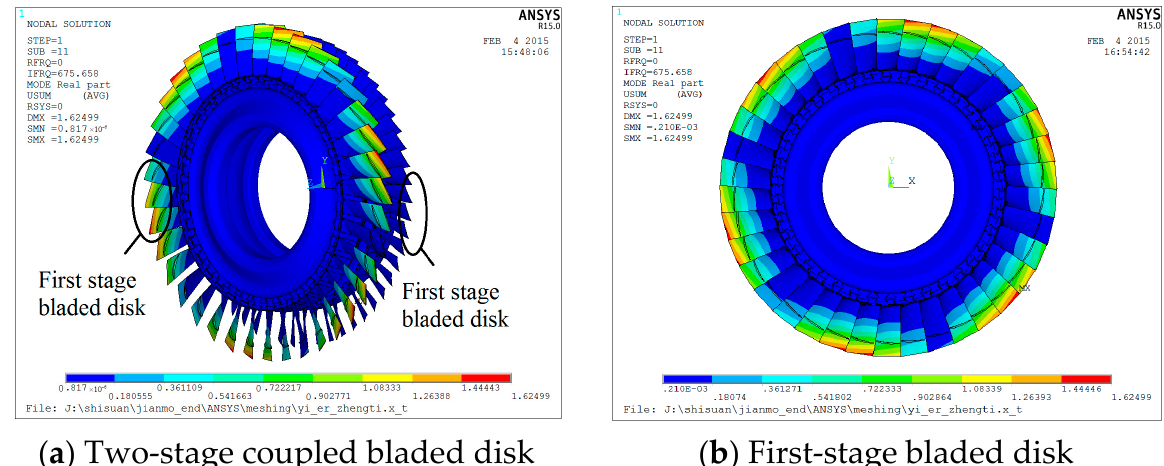
Figure 18. Coupled vibration of the blade and disk in three segments.